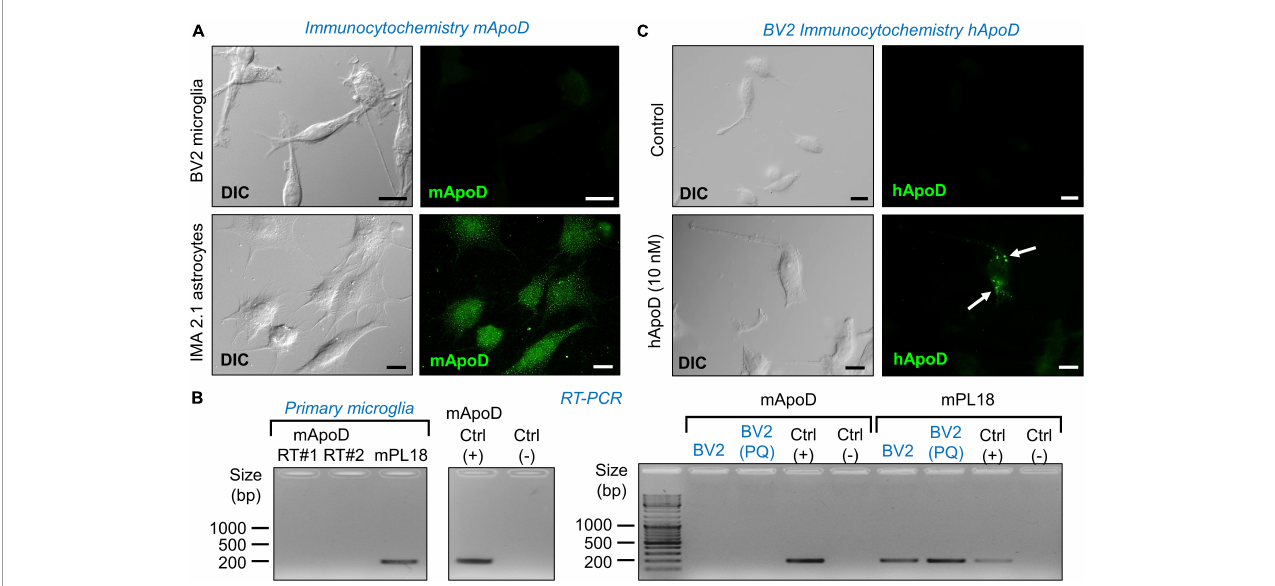
FIGURE2 Microglial cells do not express ApoD but are able to incorporate exogenous ApoD in intracellular compartments. (A) The mouse microglial cell line BV2 is not labeled by a mouse ApoD antibody, while the astrocytic cell line IMA2.1 shows a characteristic ApoD punctate pattern. (B) RT-PCR reveals the absence of ApoD mRNA transcripts in both primary mouse microglia and BV2. PQ 75 µ M for 3 h does not induce ApoD expression in BV2 cells. The gene rpl18 was used as a normalizer. RT#1&2 are two separate RT reactions from independent primary cultures. Mouse sciatic nerve expression is used as positive control. An unrelated template is used as negative control. (C) Exogenously added human ApoD (hApoD; 10 nM) is internalized to intracellular compartments of BV2 cells after 3 h exposure. Calibration bars: 20 µ